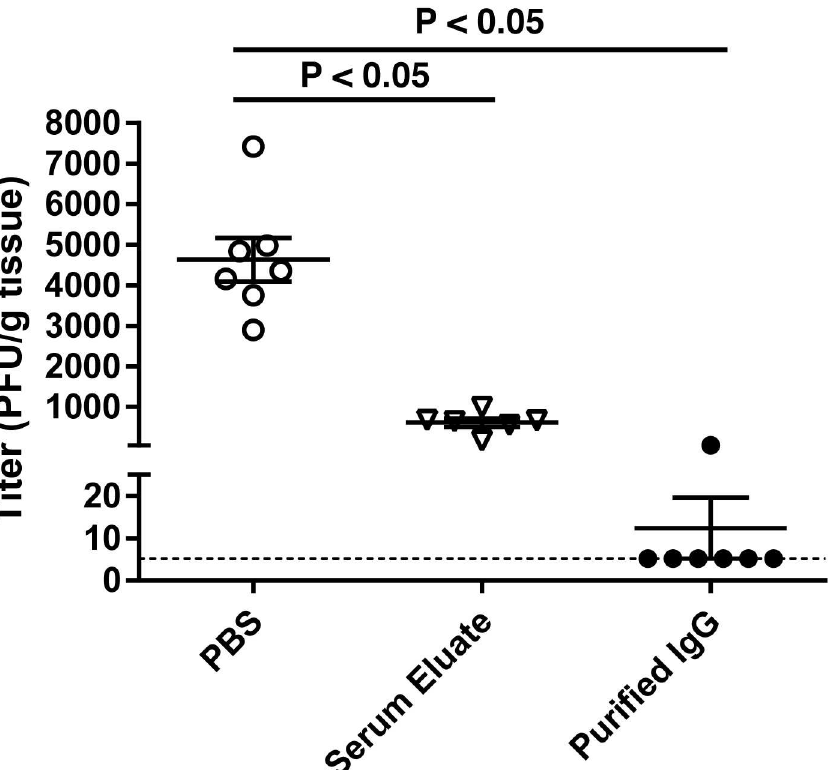
Fig 4. Reduced lung viral titers of challenged IFN- α / β R − / − mice that receivedpassive transfer of serum eluate and purified IgG from MuV-IA-immunized mice. BALB/c mice were immunizedi.n. with 1x10 6 PFU of MuV-IA in a volume of 100 μ L. Mice were boostedat 3 and 5 wpi, and serum was collectedand pooledat 8 wpi. IgG was purifiedby affinity chromatography as describedin materials and methods and dialyzedin PBS. Columneluate(referred to as serum eluate) was collectedduringIgG purification. Na ï veIFN- α / β R − / − mice receivedpassive transfer i.p. of 1 mL PBS, serum eluate, or purifiedIgG. Mice were challenged 24 hours post passive transfer i.n. with 1x10 6 PFU of MuV-IA in a volume of 100 μ L. Lungswere collectedand homogenized 2 dpi and viral titers were determined by plaqueassay in duplicate. The limit of detectionof 5.4 PFU/g tissue is represented by the dashedline. ANOVA and Tukey multiplecomparisontests were used to calculate P values.